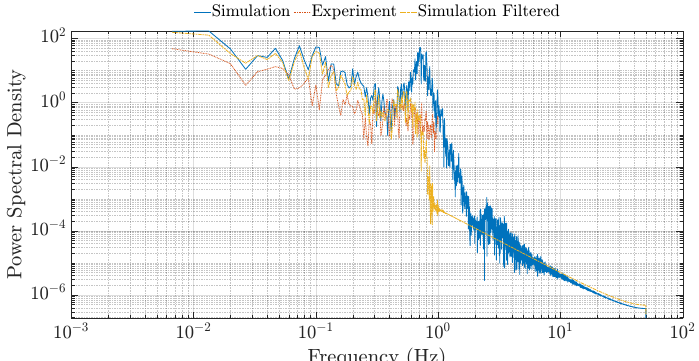
Figure 12. Power spectral density of the ground station angular velocity for the spring-disc model with and without a low pass filter applied.